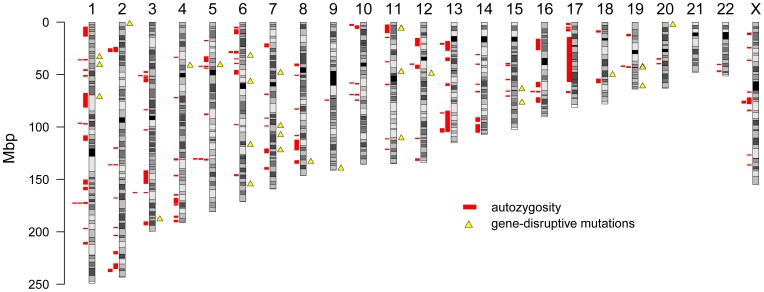
Overview of sequenced genomes.Ideograms of the autosomes and X chromosome are shown. Red bars represent segments of autozygosity observed in five individuals with asthma (parents of the sequenced trios) and yellow triangles represent asthma-specific gene-disruptive SNVs or indels. The regions of autozygosity in multiple cases on chromosomes 1q and 5q were also observed to be autozygous in at least one control individual.